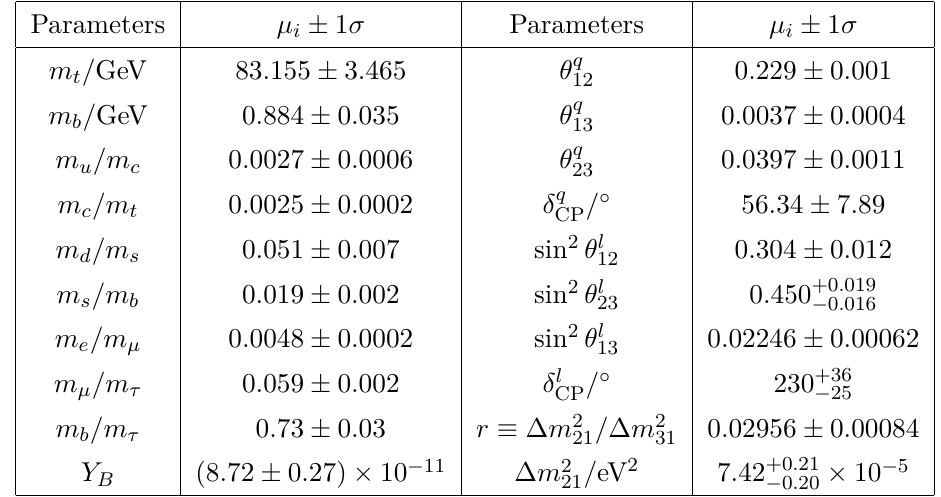
Table 2 . The best fit values µ i and 1 σ uncertainties of the quark and lepton parameters when evolved to the GUT scale as calculated in [109], with the SUSY breaking scale M SUSY = 500 GeV and tan β = 10 , where the error widths represent 1 σ intervals. The values of lepton mixing angles, leptonic Dirac CP violation phases δ l and the neutrino mass squared difference are taken from CP NuFIT 5.1 [110] for normal ordering neutrino masses with Super-Kamiokande